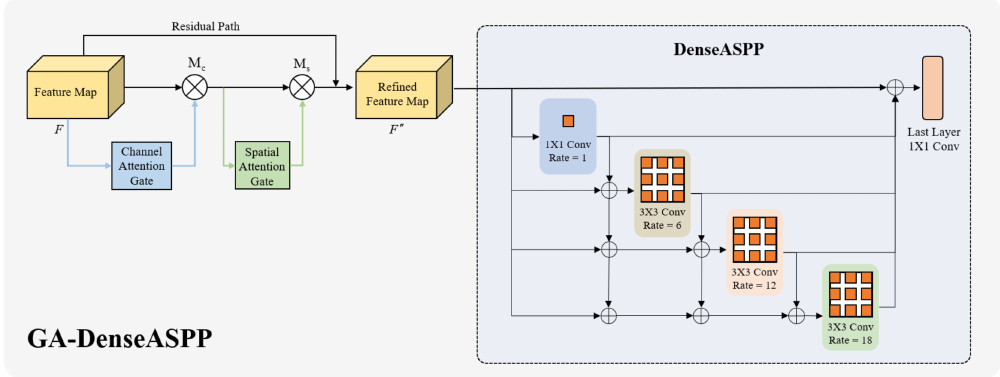
Figure 4. GA-DenseASPP Module.